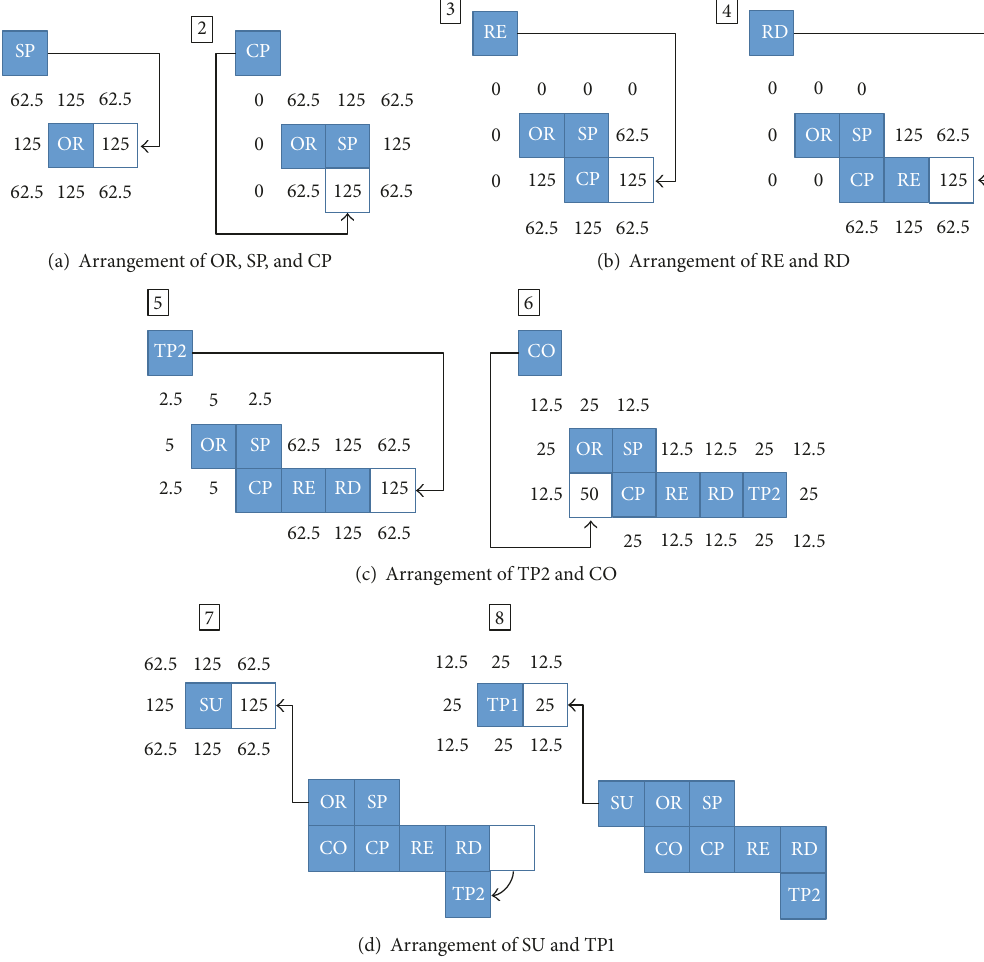
Figure 7: Layout modification process.